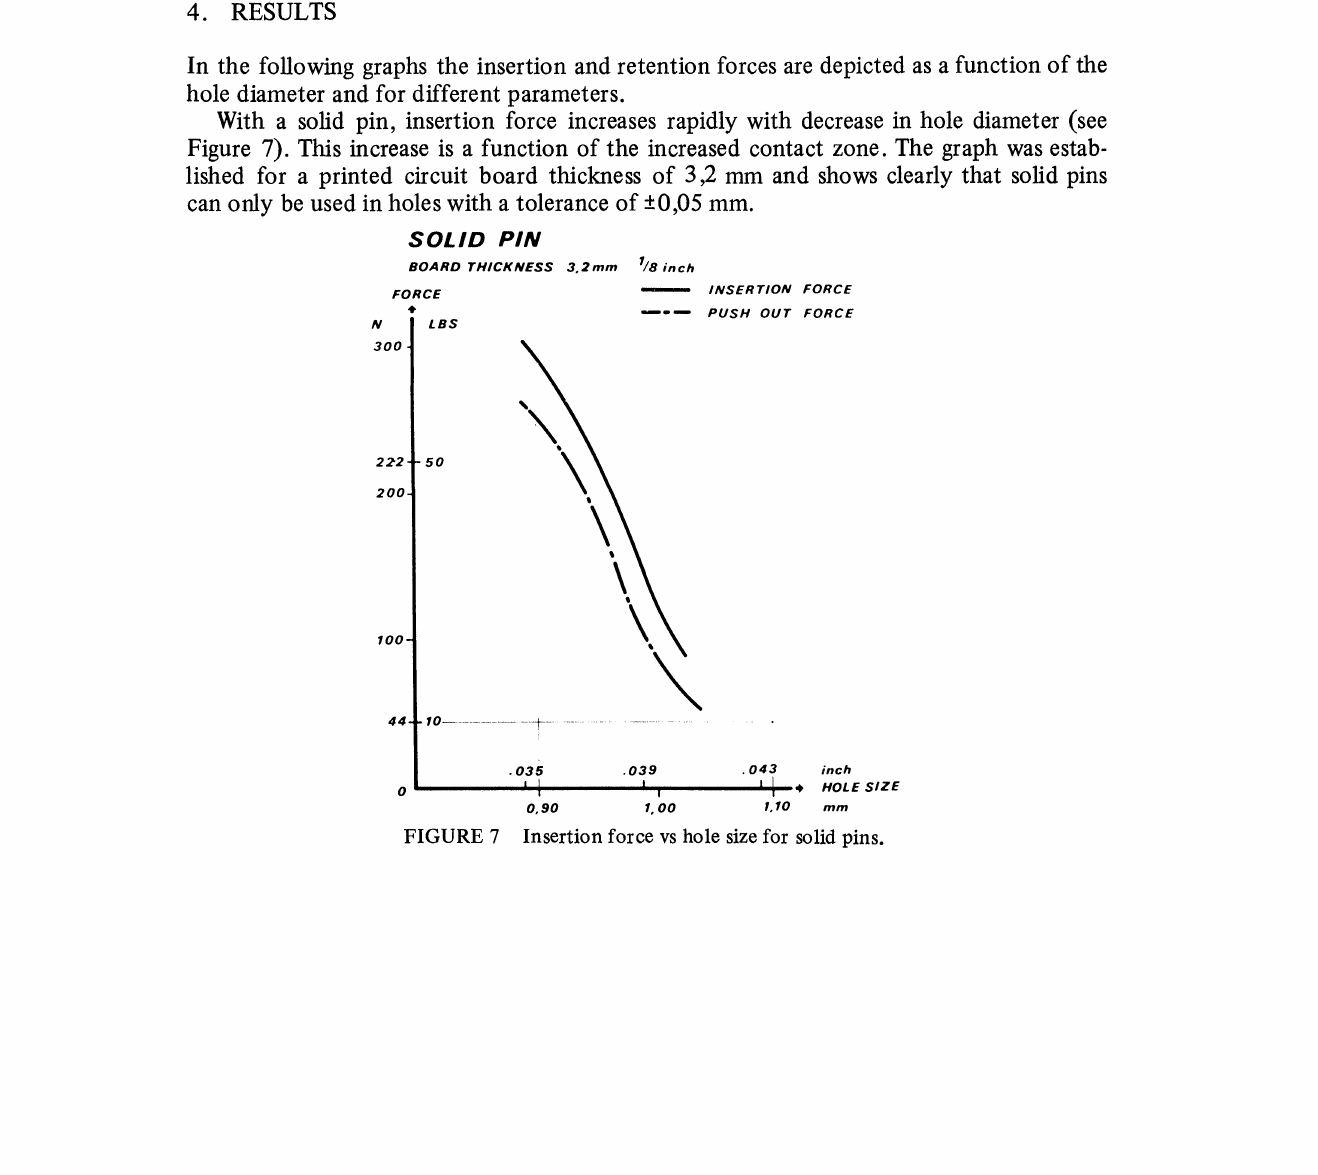
FIGURE 7 Insertion force vs hole size for solid